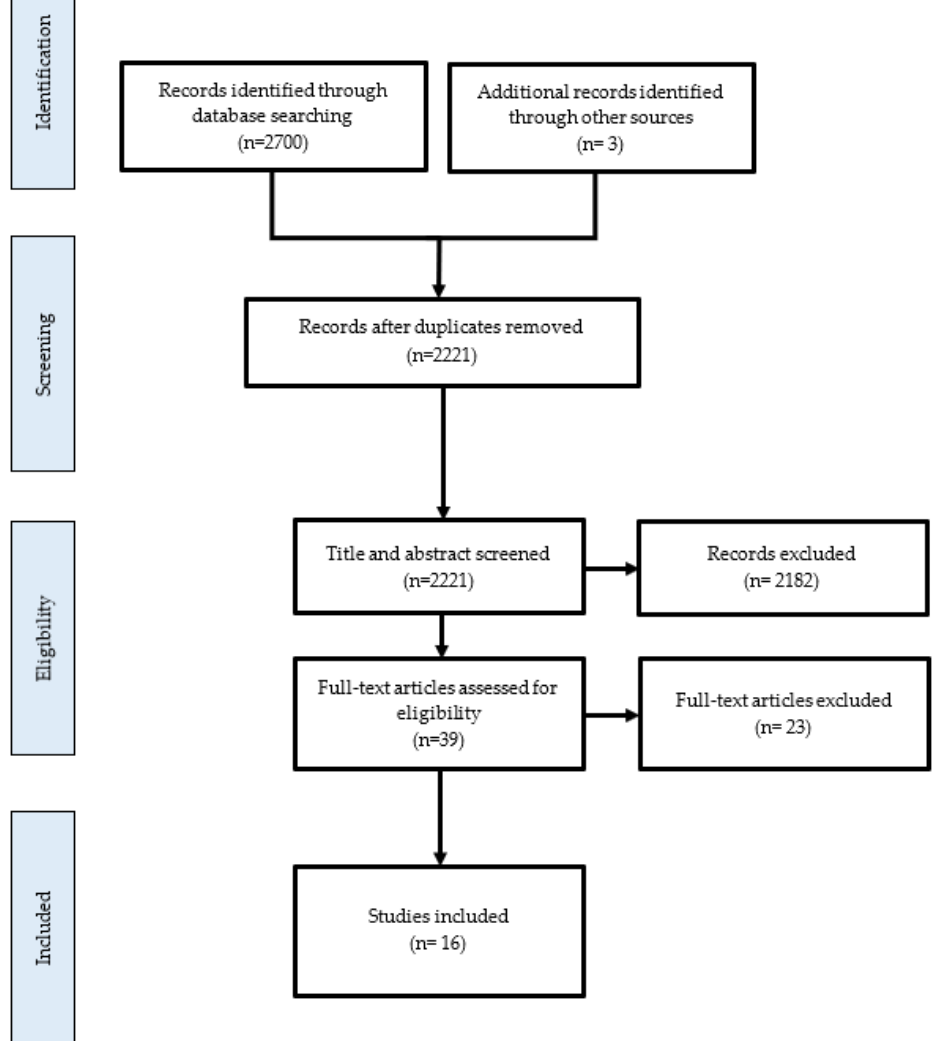
Figure 1. Flowchart of selection of sources of evidence.